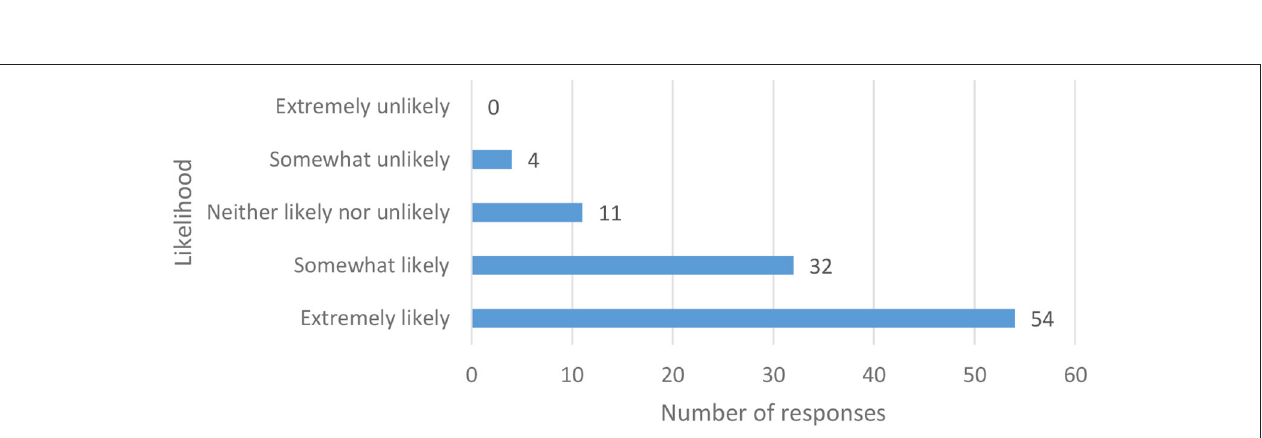
Frontiers in Sports and Active Living |